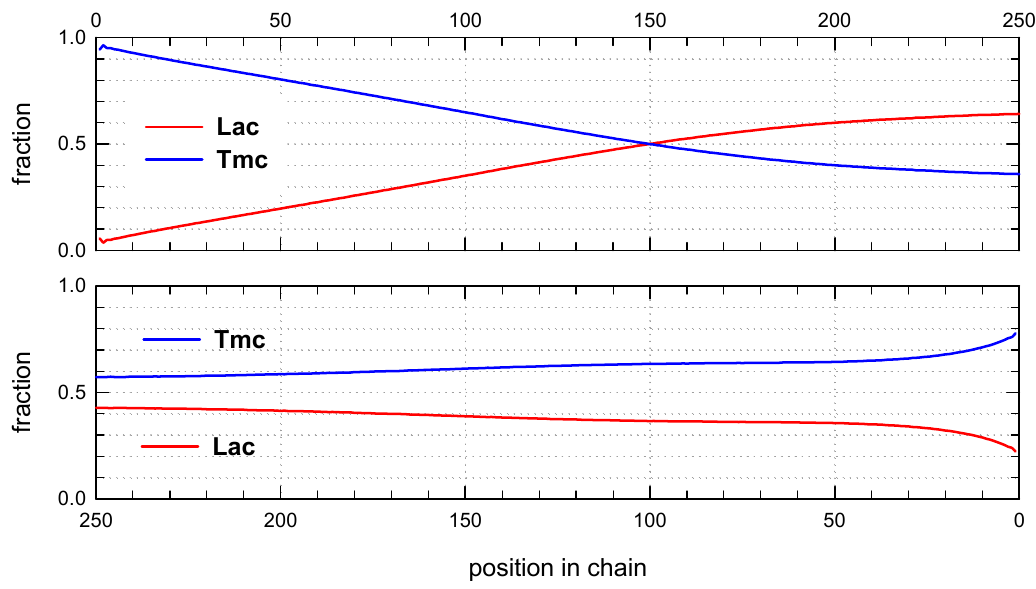
Figure 11. Distribution of copolymer units along chain for conditions given in Figure 10. Chain positions numerated from chain beginning ( top ) and from active center ( bottom ).